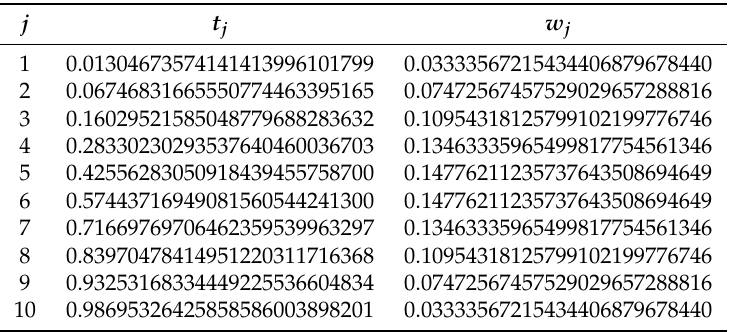
Table 4. Values of abscissas t j and weights w j .